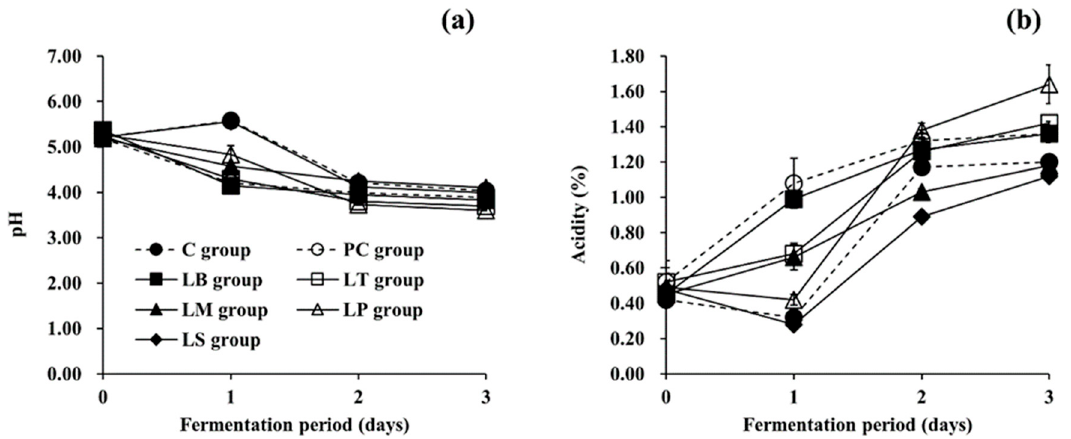
Figure 1. Changes in physicochemical properties of Baechu kimchi during fermentation. ( a ) pH, ( b ) acidity. • : C group without an inoculum (control), ○ : PC group inoculated with tyramine-producing L. brevis isolated from kimchi product (positive control), ■ : LB group inoculated with BA-degrading L. brevis PK08, □ : LT group inoculated with BA-degrading L. pentosus PK05, ▲ : LM group inoculated with BA-degrading Leu. mesenteroides YM20, △ : LP group inoculated with BA-degrading L. plantarum KD15, ◆ : LS group inoculated with BA-degrading L. sakei YM21.